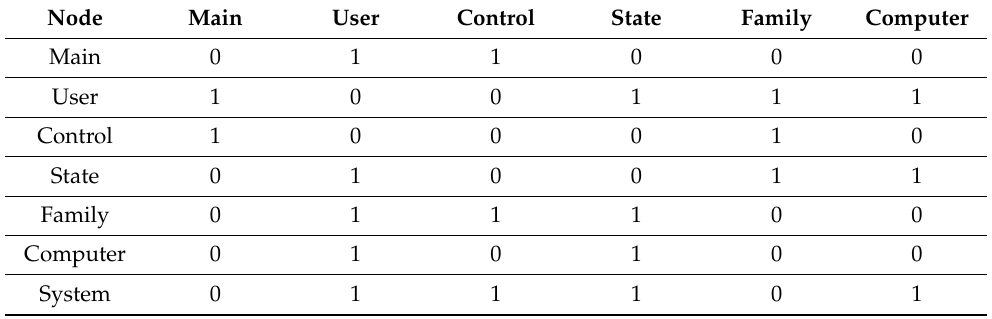
Table 3 represents sample data for the input matrix used to save the number of edges between each node until the total number of nodes is achieved. Table 4 represents each node, which belongs to a specific cluster (label) which indicates the total number of clusters. Table 3. The built input matrix.